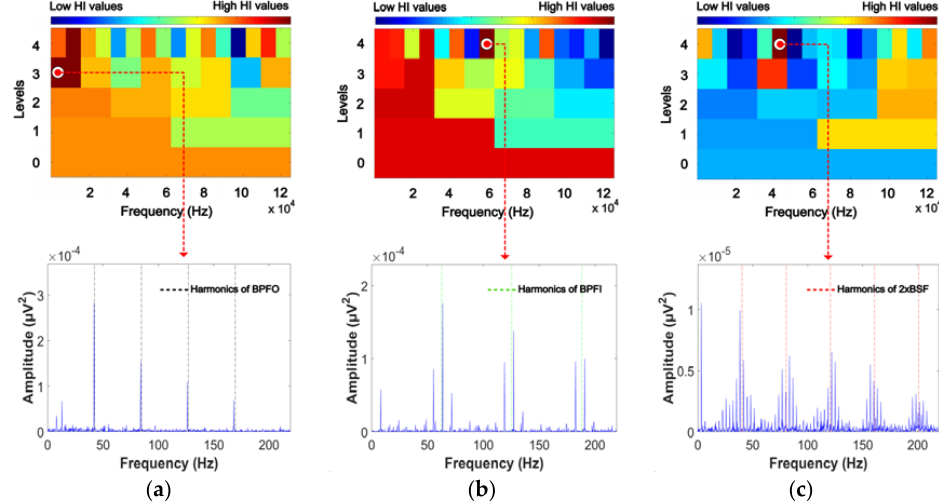
Figure 6. 2D visualization analysis for optimal sub-band selection corresponding to the highest HI values of ( a ) BCO, ( b ) BCI, and ( c ) BCR.